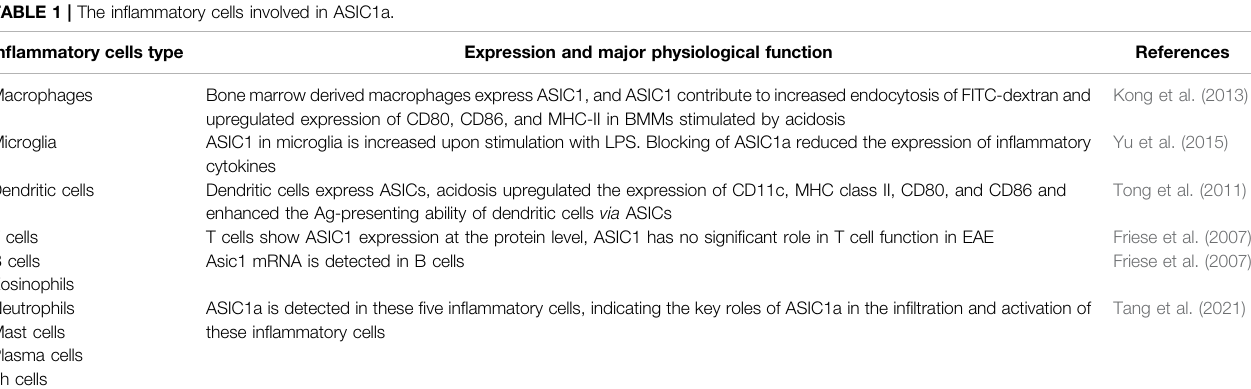
TABLE 1 | The in fl ammatory cells involved in